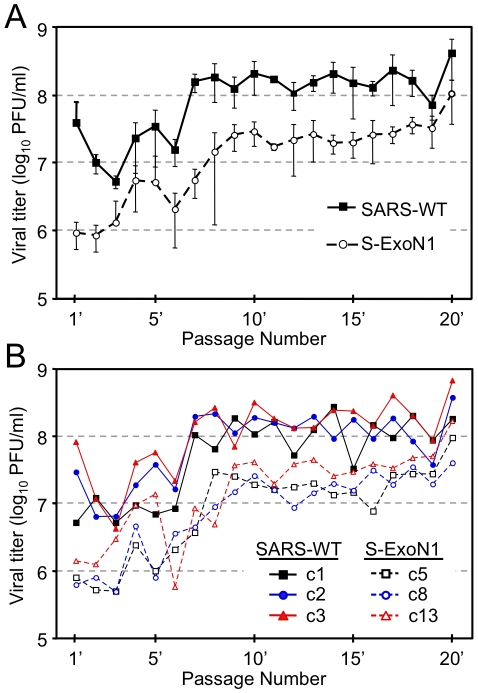
SARS-WT and S-ExoN1 titers across 20 population passages.(A) Mean viral titers of three clones each of SARS-WT and S-ExoN1 at passages 1'-20'. Error bars indicate standard deviations. (B) Viral titers of individual clones of SARS-WT (closed symbols, solid lines) and S-ExoN1 (open symbols, dashed lines) at passages 1'-20'. At each passage Vero cells were infected at an MOI of 0.1 PFU/cell. Samples of culture medium were collected at 24 h p.i., titered by plaque assay at each passage, and transferred to naive cells.